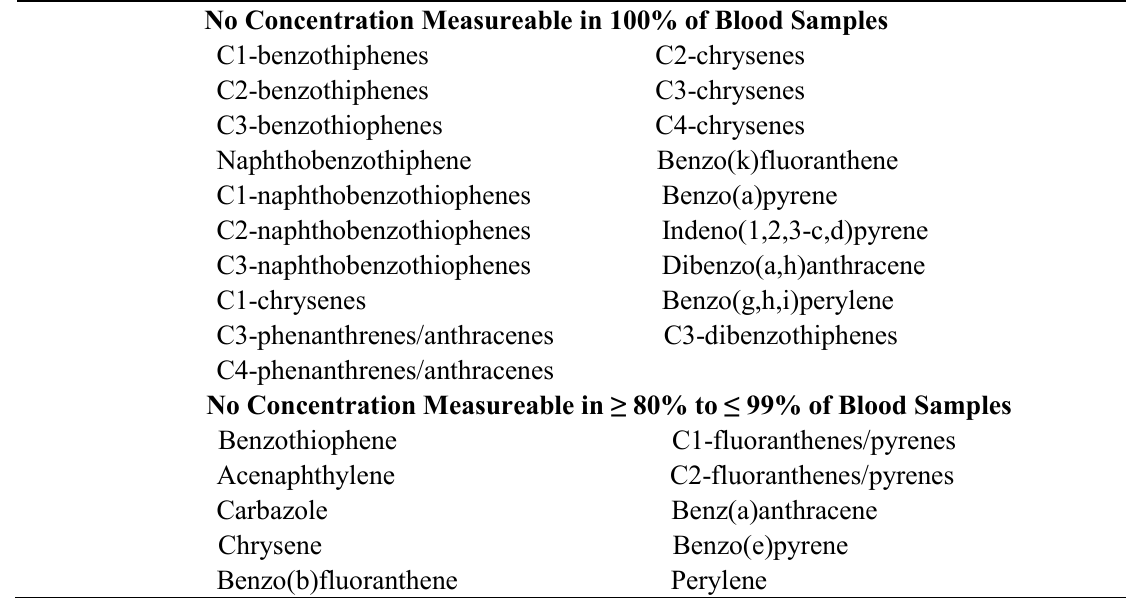
Table 2. Summary of PAHs either not found or infrequently measurable in maternal and cord